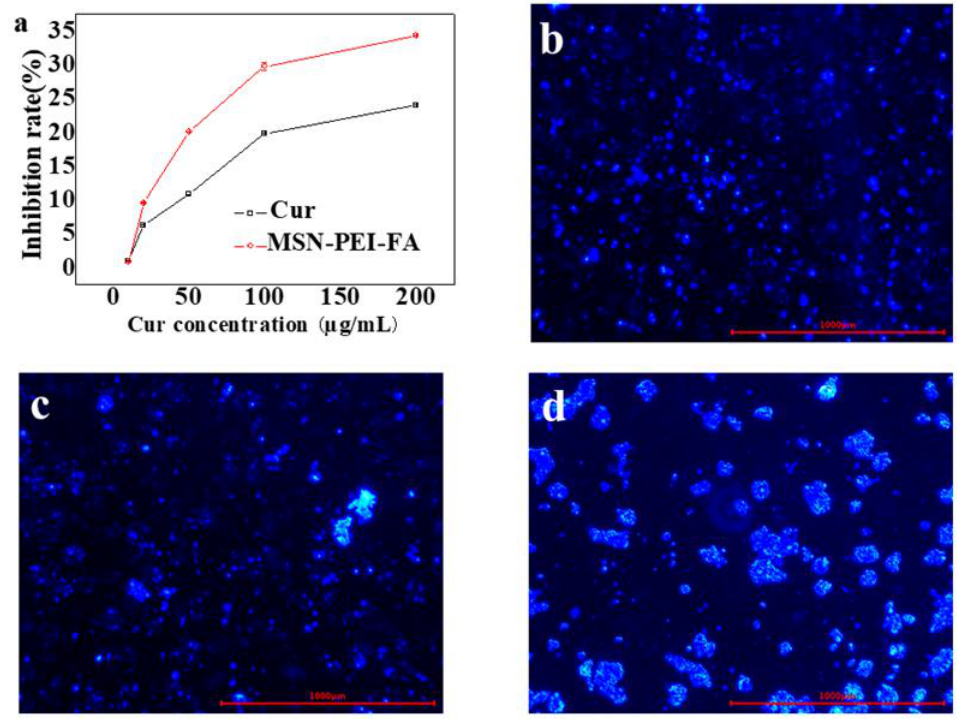
Figure 6 . ( a ) Inhibition rate of Cur and MSN-PEI-FA / Cur; fluorescence microscopic images of LS174T for coumarin-loaded MSN ( b ), MSN–PEI ( c ), and MSN–PEI-FA ( d ) intake experiments. “The MTT method was used to evaluate the cytotoxicity of MSN-PEI-FA / Cur on colon cancer cells. MSN-PEI-FA / Cur solution of concentrations of 10–200 µ g / mL was prepared in PBS”. The authors would like to apologize for any inconvenience caused to the readers by these changes.